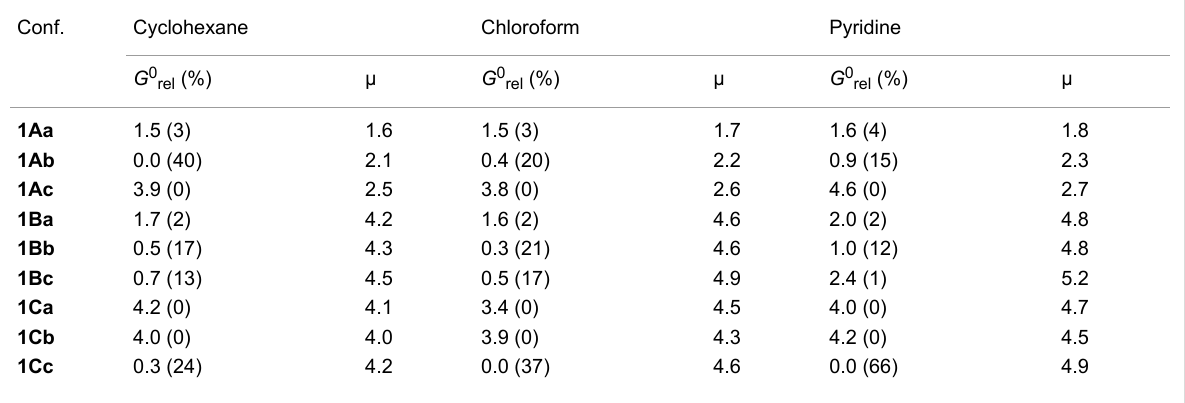
Table 2: Relative standard Gibbs free energies (in kcal mol − 1 and Gibbs population in parenthesis) and molecular dipole moments (in Db) for the conformers of 1 , calculated at the ω B97X-D/6-311++g(d,p) level.